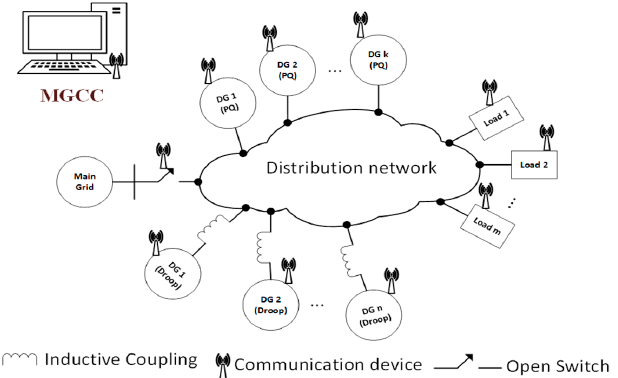
Figure 2. Islanded microgrid representation with loads, droop controlled distributed generators (DGs) and PQ DGs.